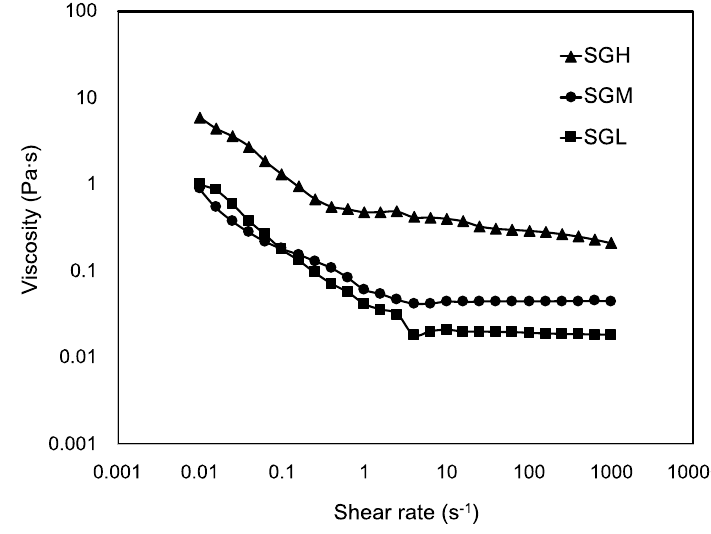
Figure 3. Steady shear viscosity (25 °C) of SG samples with controlled molecular weight.